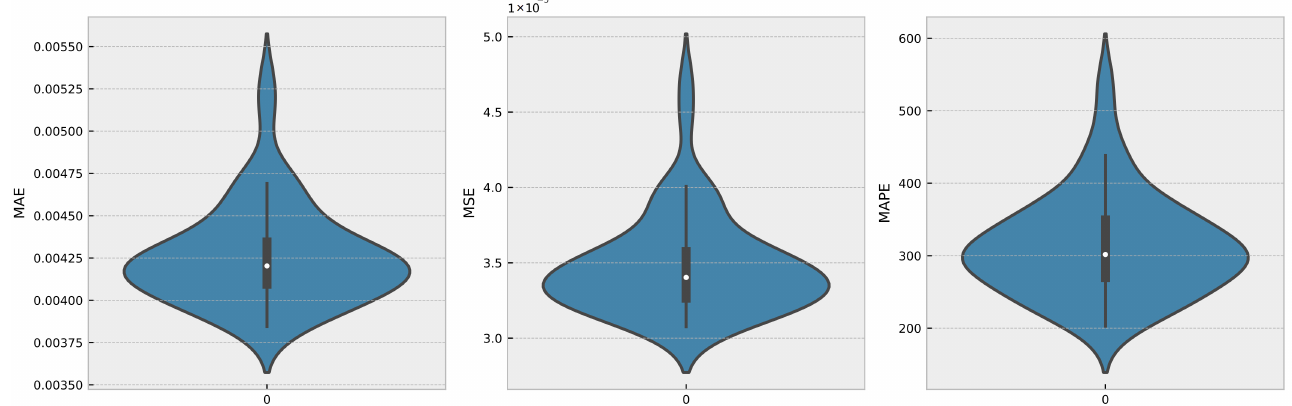
Figure 8. Violin of MSE, MAE, and MAPE for 50 runs with Gaussian